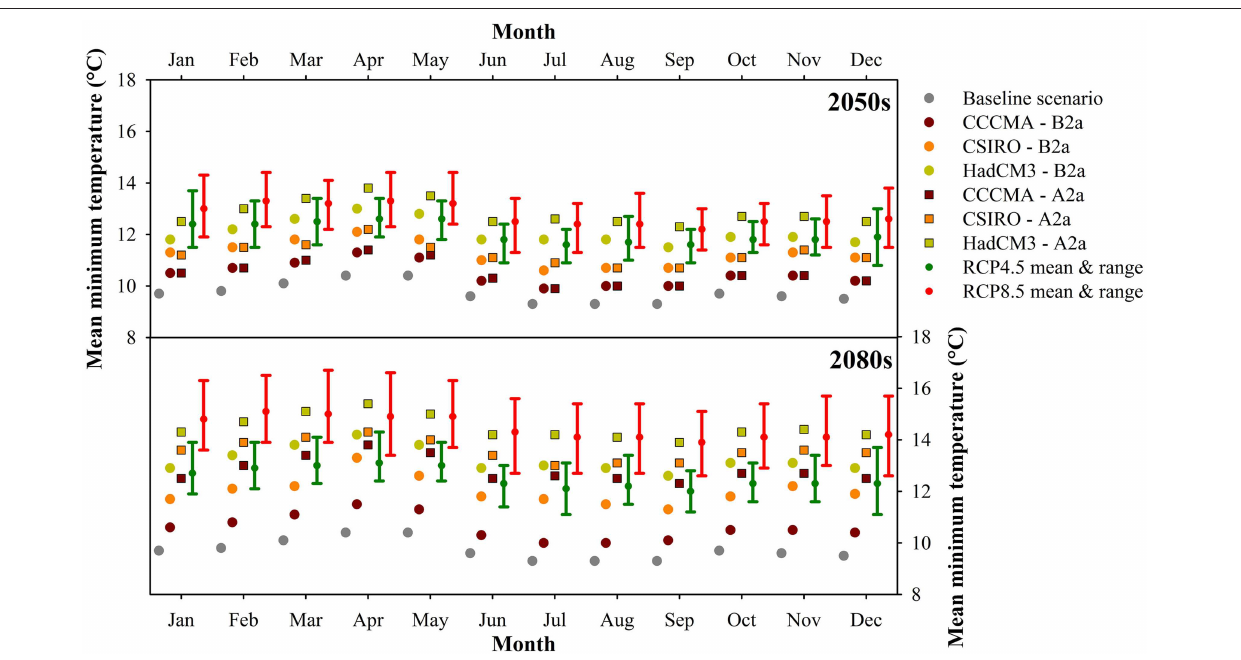
FIGURE 1 | Mean daily minimum temperature for each month at the baseline location, according to different climate datasets: gray dots show current conditions according to the WorldClim database, brown, orange, and yellow circles (B2a emissions) and squares (A2a emissions) indicate projections with the CCCMA CGCM2, CSIRO MK2, and HadCM3 climate models, according to AR4 scenarios used in this study. The green and red dots with error bars show the means and ranges of projections from the AFRICLIM climate model ensemble ( Platts et al., 2015), which uses projections from 10 General Circulation Models for the RCP4.5 and RCP8.5 radiative forcing scenarios of the 5th Assessment Report of the IPCC (2013), downscaled with five Regional Climate Models and additional statistical downscaling procedures (details on the methodology and models used are in the main